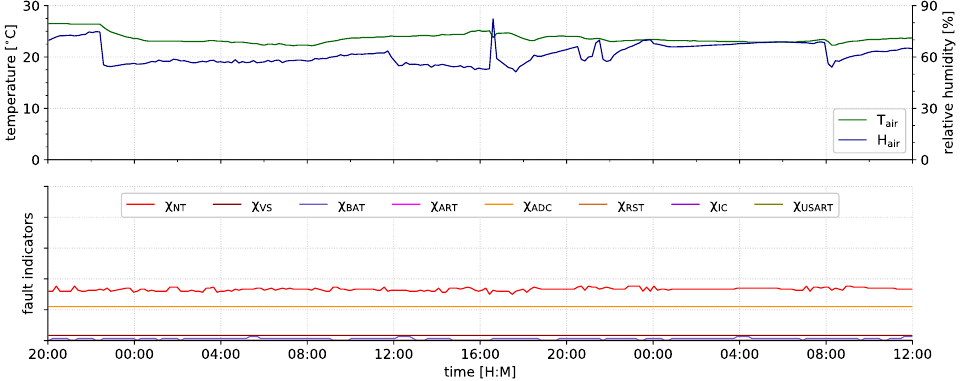
Figure 18. Example of a proper event distinguishable via the fault indicators.